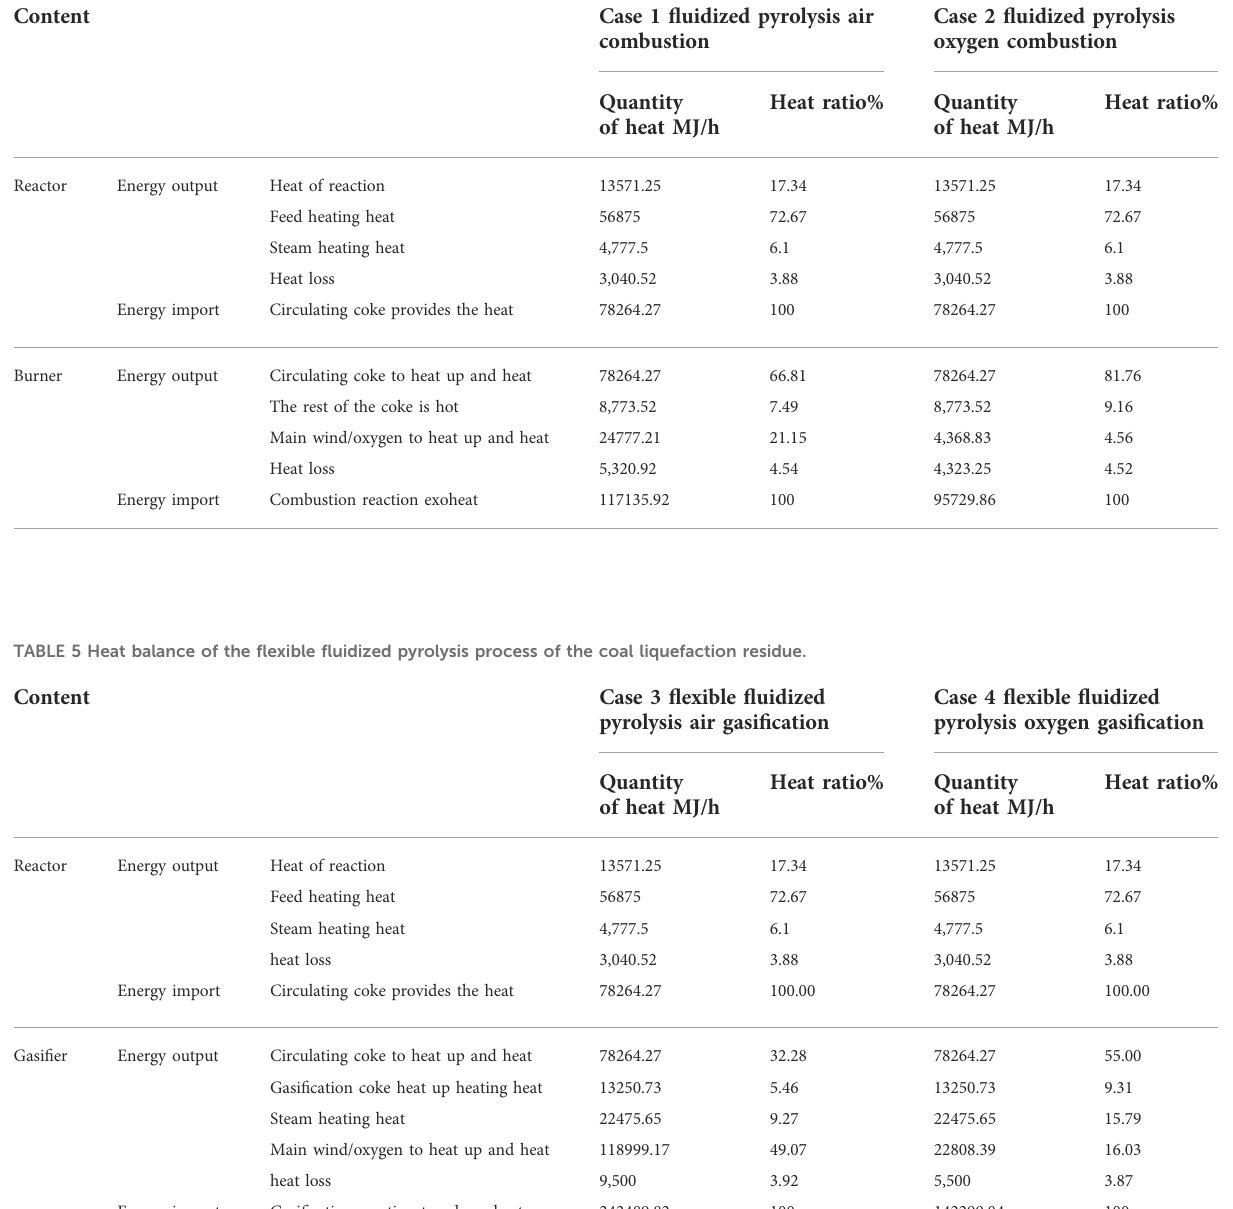
TABLE 4 Heat balance of the fl uidized pyrolysis process of the coal liquefaction residue. Content